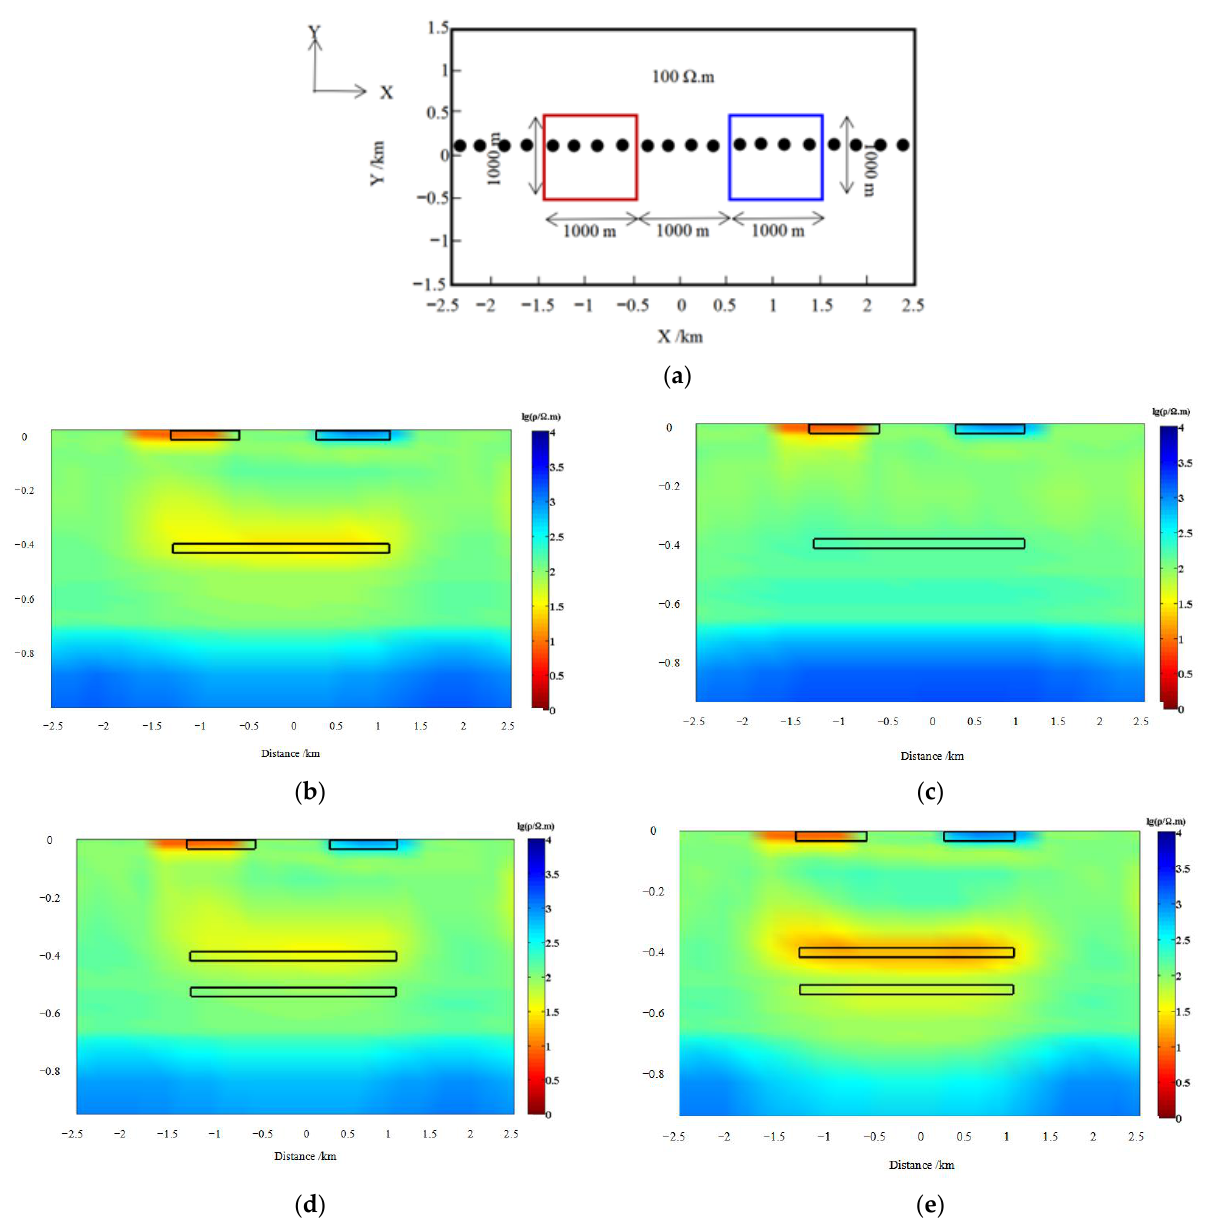
Figure 5. Schematic diagram of the theoretical measuring line and 3D inversion results of different models. ( a ) A typical profile in X-direction on the surface of one 3D model. The black dots represent the locations of the measurement points, the red boxes circle the shallow low-resistive target bodies (10 Ω · m), and the blue boxes circle the shallow high-resistive bodies (1000 Ω · m); from ( b – e ): three- dimensional impedance tensor inversion results of single- or double-target models — the black boxes show the positions of the real anomalies in each model, respectively.